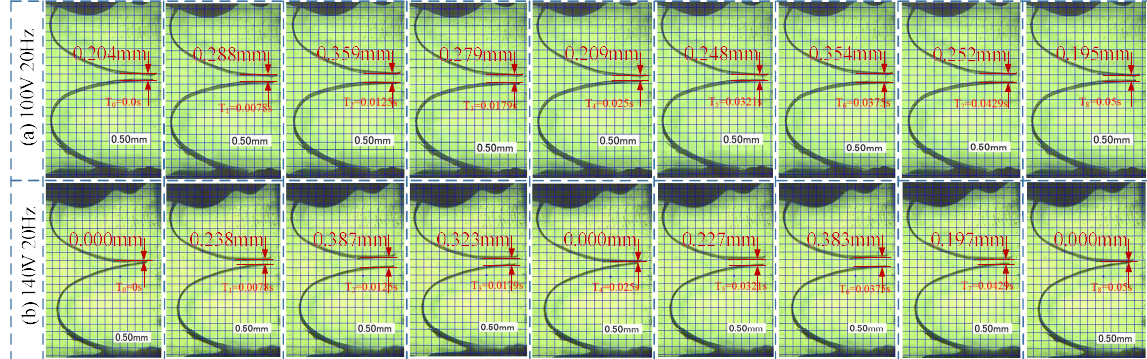
Figure 6. The fluctuation of CVLSs in one cycle. ( a ) 100 V 20 Hz; ( b ) 140 V 20 Hz.